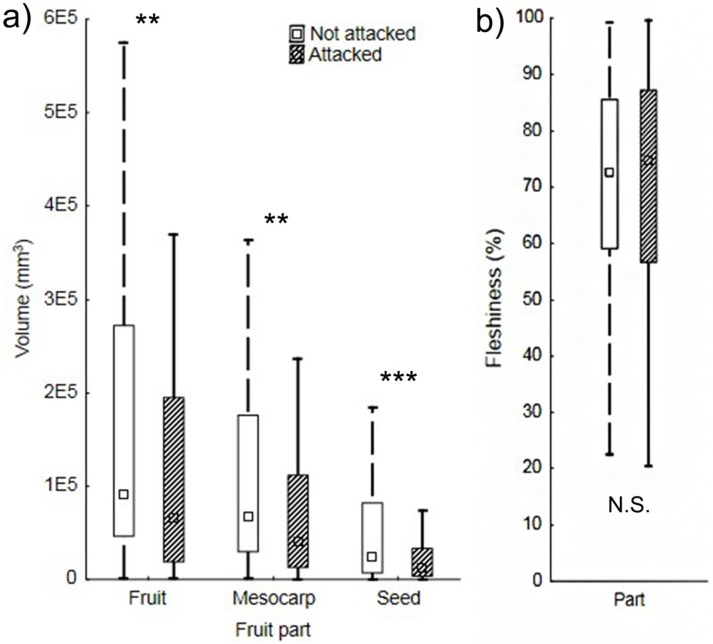
Mean volume for whole fruit, mesocarp and seeds (a) and fleshiness (b) in plant species attacked and not attacked by Lepidoptera.The differences between attacked and non-attacked species are significant (whole fruit: U 106,151 = 5624, Z = 3.064, P = 0.002; mesocarp: U 106,151 = 5828, Z = 2.69, P = 0.007; seeds: U 106,151 = 5346, Z = 3.574, P < 0.0010), (b) Fleshiness (i.e. proportion of mesocarp in whole fruit) did not have significant effect on infestation (U 106,151 = 6839, Z = 0.83, P = 0.401).